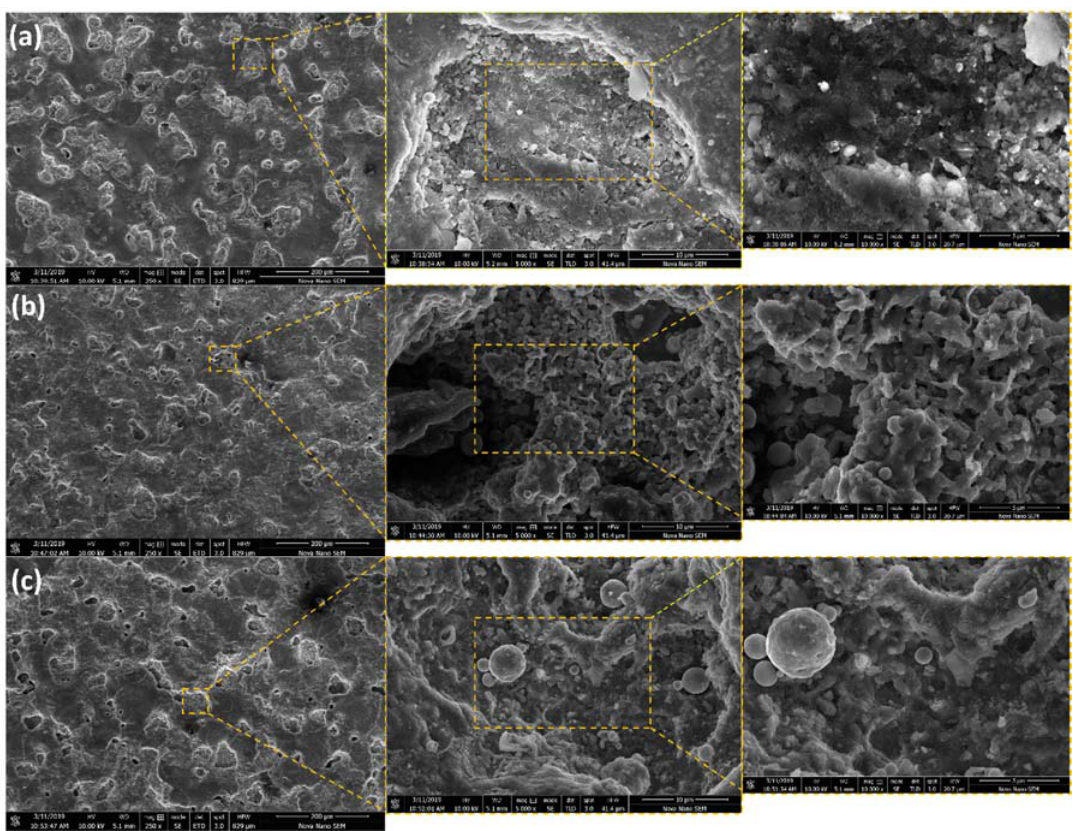
Figure 6. Surface morphology: Nano-porosity in PMEDMed modified surface of Ti6Al4V ELI Grade 23 on 5A and Si powder concentrations ( a ) 5 g/L ( b ) 10 g/L ( c ) 20 g/L on 250×, 5000× and 10000× magnifications.